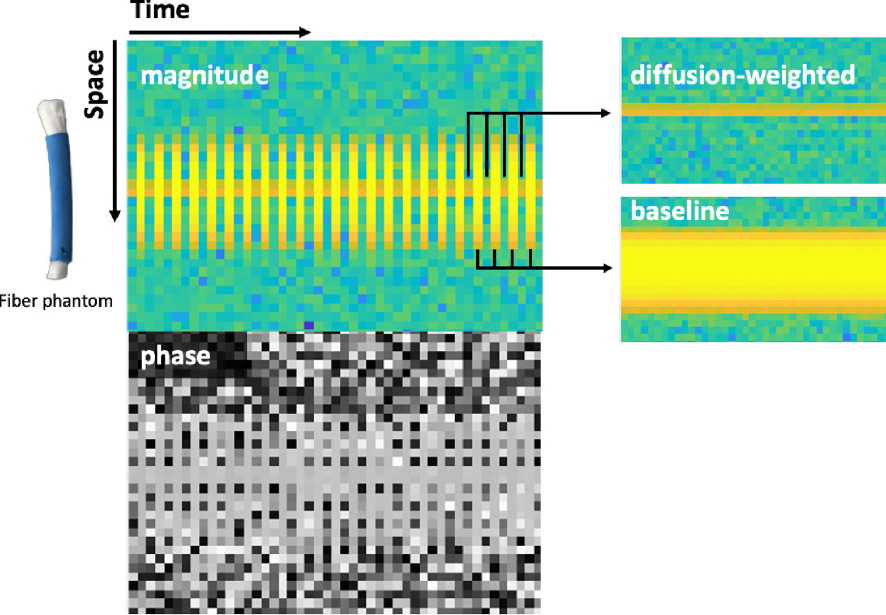
Fig 9. The magnitude and phase image acquired with the 1DFT STEAM sequence (left). The space dimension of the images correspond to the z-axis of the coil insert as shown in Fig 7.Lines with and without diffusion-weighting are alternated. On the right, the separated magnitude images with diffusion weighting (top) and without (bottom) are shown. When the diffusion gradients are on, signal away from the saddle point is dephased.